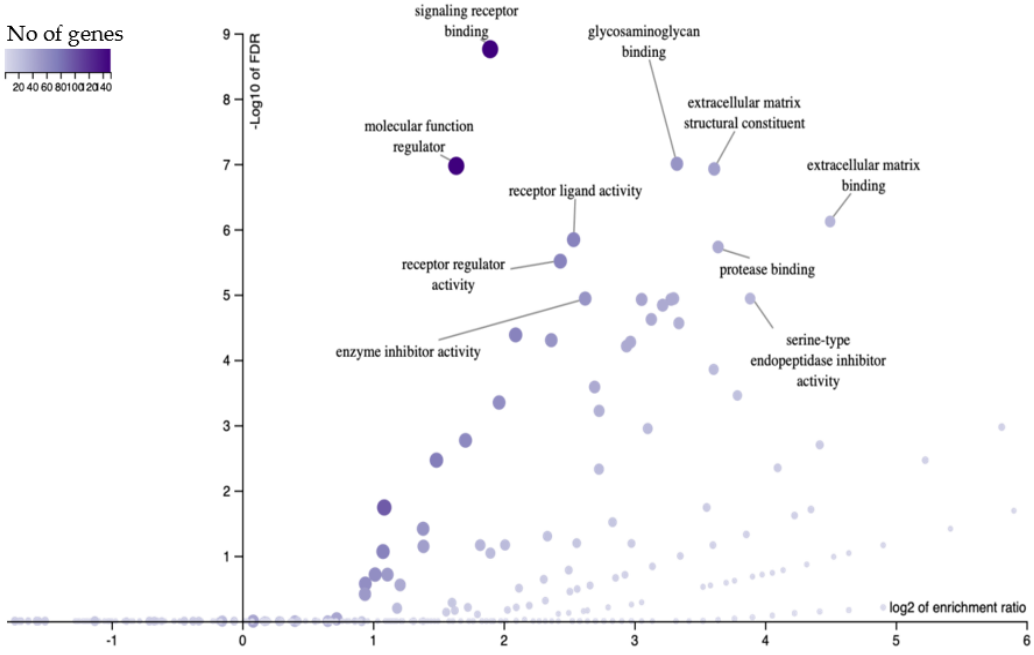
Figure 2. Gene Ontology (GO) enrichment analysis. Molecular function of differential expressed endometrial epithelial surface genes were identified using the over-representation analysis tool. The X axis reports gene enrichment in the GO term and the Y axis the statistical significance of over- representation (negative log 10 false discovery rate). The size of dot reflects the number of genes in each GO term and the colour reflects the number of genes in the sample matching the term.